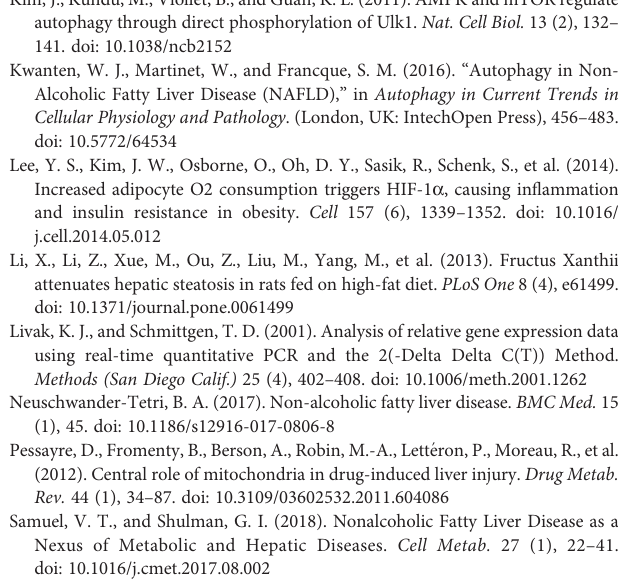
SUPPLEMENTARY FIGURE 1 | The viability of HepG2 cells treated with FFA. Cell viability was analyzed by CCK-8 assay. Data are expressed as mean ± SD (n=3). SUPPLEMENTARY FIGURE 2 | Changes of basic metabolism of mice treated with low-concentration ATR. 16 male C57BL/6 mice were (4 mice/4 treatments) intraperitoneal injected withdifferent concentrations (0.5, 1, and 2 mg/kg) ofATRfor 2 weeks. (A) Body weight gain of mice in 14 days. (B) Relative weight of liver, kidney, and Epididymal fat of mice. (C) Body Temperature changes of mice in 14 days. (D) (E) (F) The level of alanine aminotransferase (ALT), aspartate aminotransferase (AST), and triglycerides (TG) in serum and liver homogenate. (G) H&E staining of liver and kidney slices. Data are expressed as mean ± SD (n=4). * P<0.05, ** P<0.01 ( * represents ATR groups compared with the control group). SUPPLEMENTARY FIGURE 3 | BODIPY-stained LD level in HepG2 cells. (A) Representative confocal images of LDs stained by BODIPY and counterstained by DAPI. Scale bars: 50 m m. (B) Optical density analysis of fl uorescence intensity. Data are expressedas mean±SD(n=3). ** P<0.01 ( * represents the FCgroupcompared with the NC group). # P<0.05 ( # represents FC+ATR treatments compared with the FC group). NC=normal group, and FC=FFA